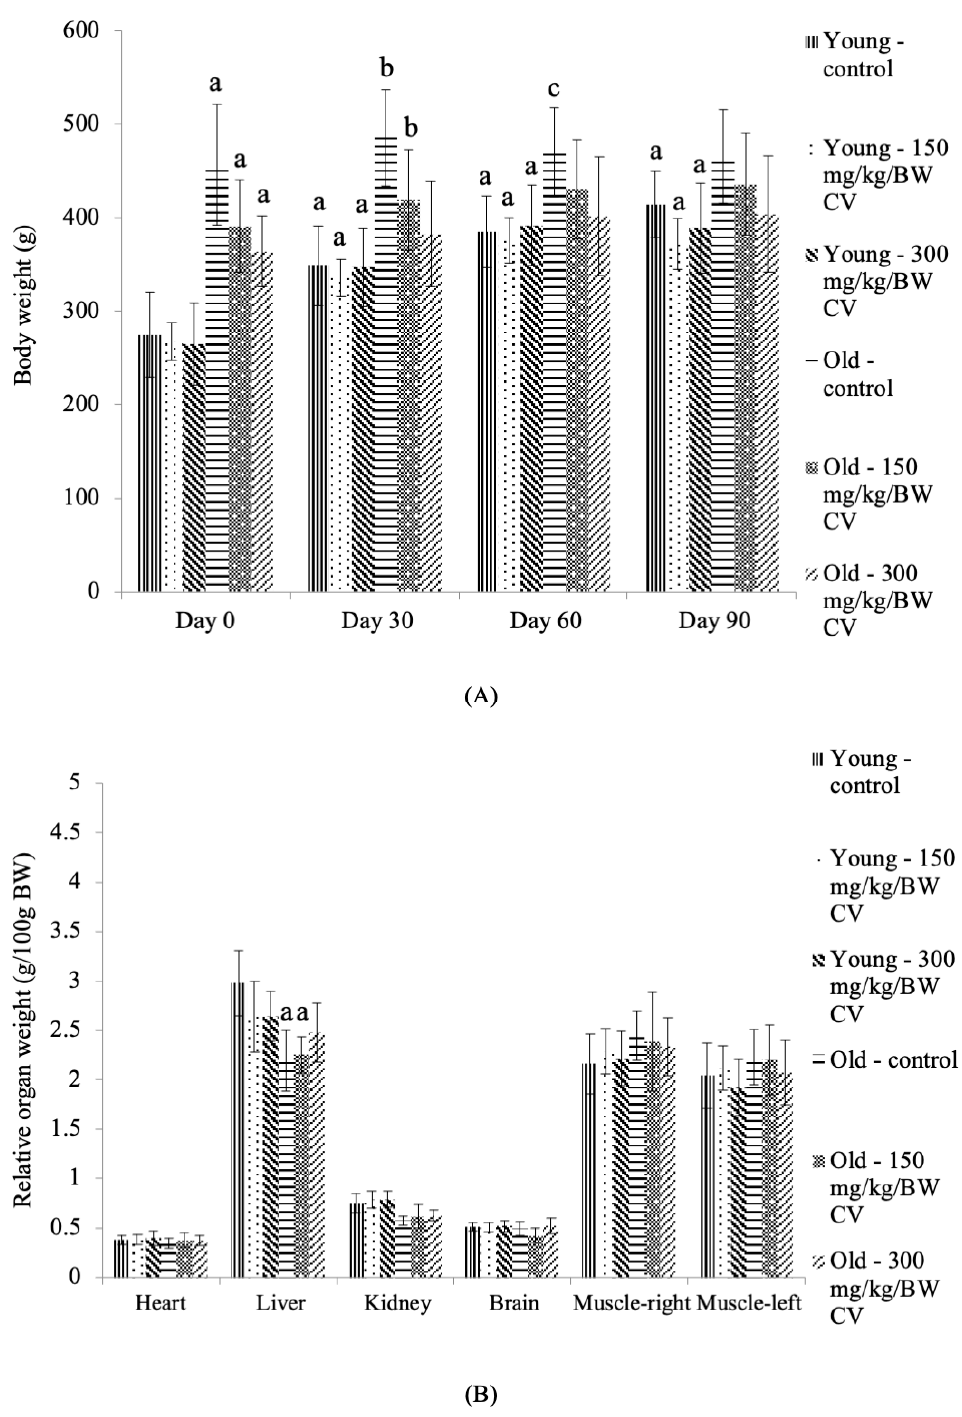
Figure 1. The ( A ) body weight and ( B ) relative organ weight of the young and old rats. The data are presented as the mean ± SD, n = 8 (control rats), n = 10 ( C. vulgaris -treated rats). a p < 0.05 significantly di ff erent compared to the control young rats on Day 0, b p < 0.05 significantly di ff erent compared to the control young rats on Day 30, c p < 0.05 significantly di ff erent compared to the control young rats Day 60, with a post hoc Tukey HSD test. BW: Body weight; CV: C. vulgaris